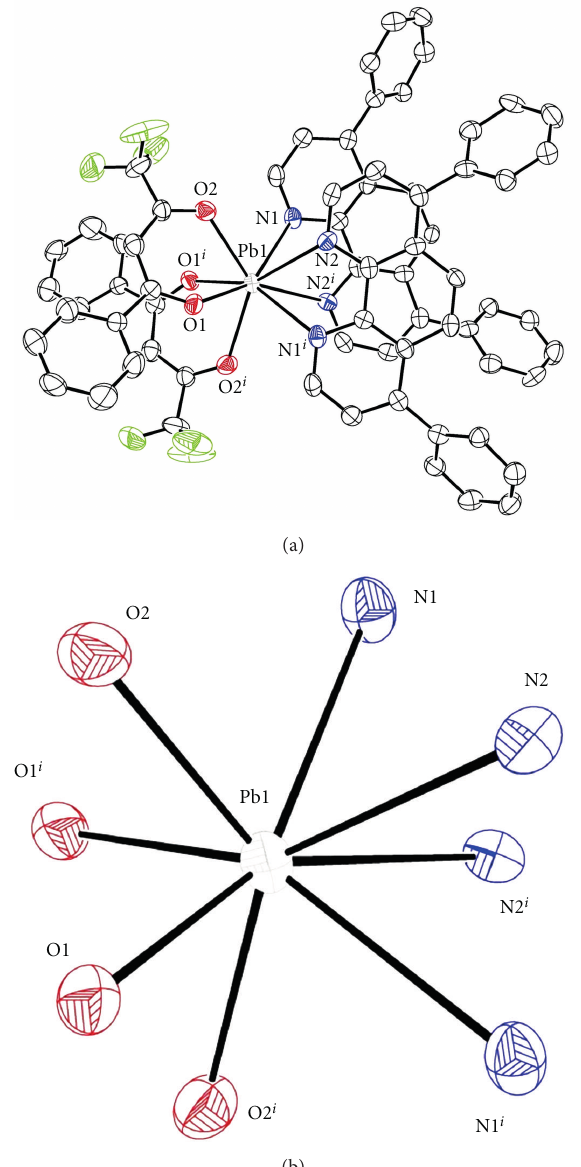
F 2: (a) Ortep diagram of complex 1 . (b) Representation of the hole in the coordination sphere of 1 . e coordination geometry is as holodirected [symmetry code (